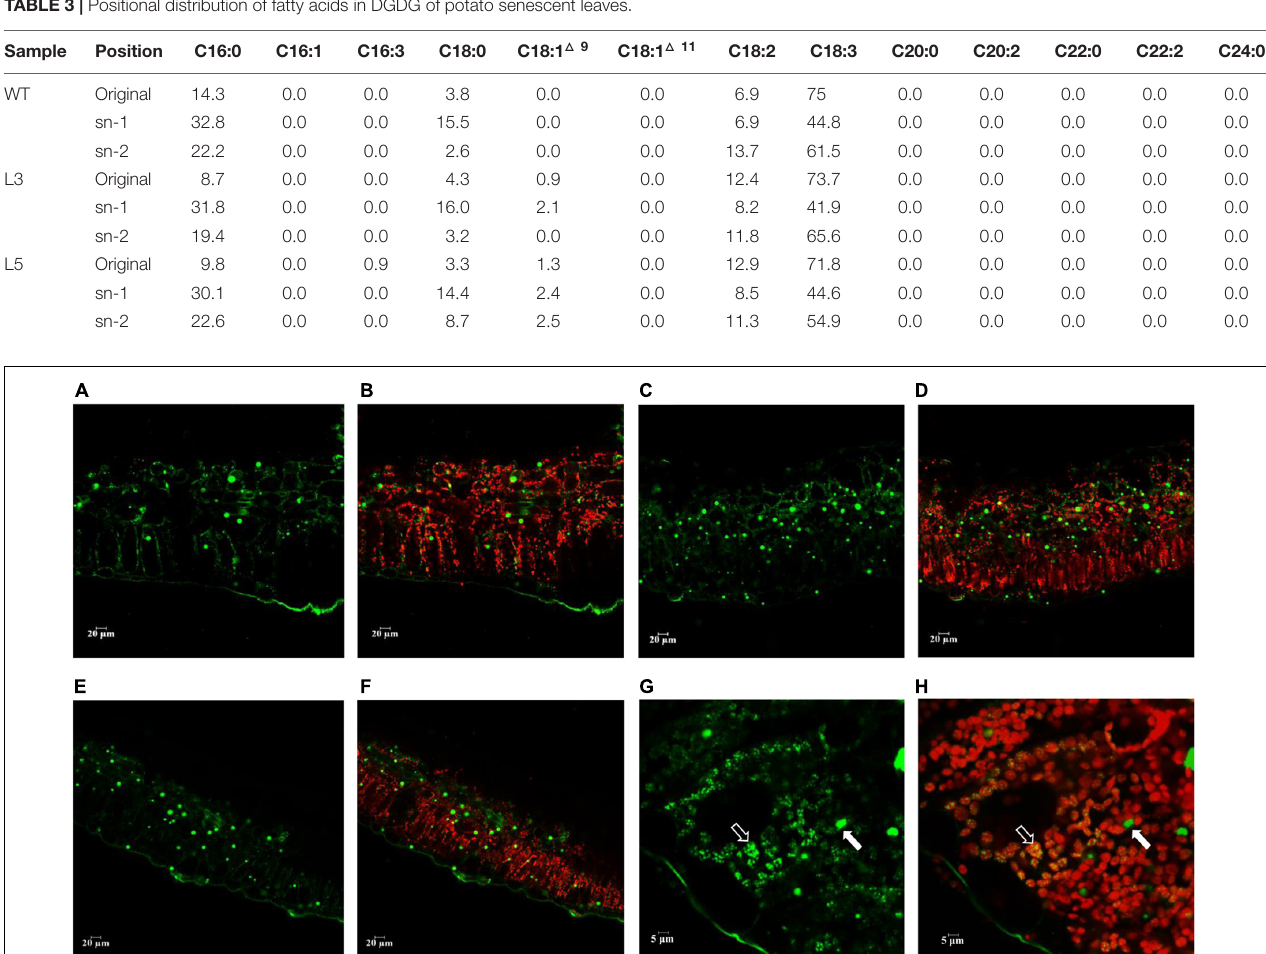
TABLE 3 | Positional distribution of fatty acids in DGDG of potato senescent leaves. Sample